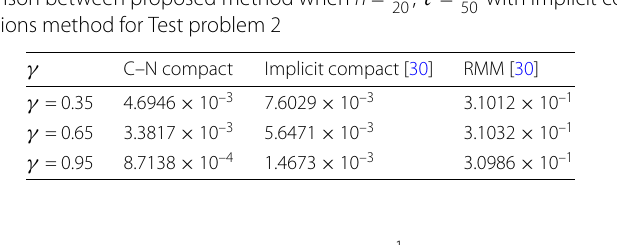
, τ = 1 with implicit compact and 20 50